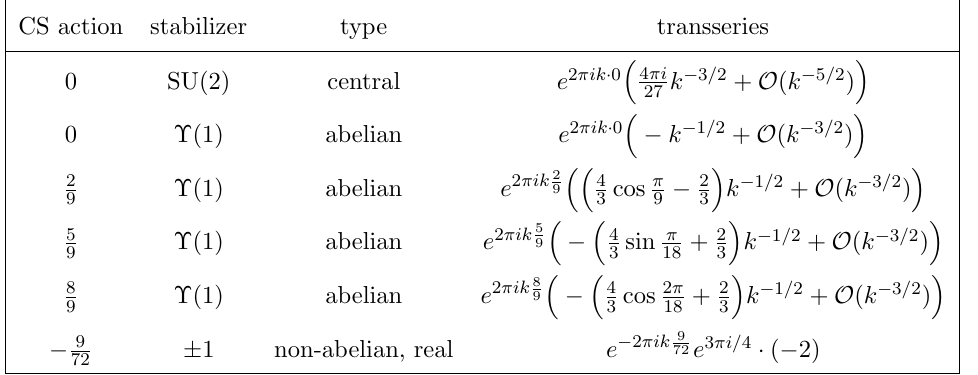
Table 20 . Transseries and classi(cid:12)cation of (cid:13)at connections on M ( factor of iq (cid:0) 45 = 72 = 2 p 2. The corresponding Weil representation is m + K = 18 + 9. (cid:0) Open